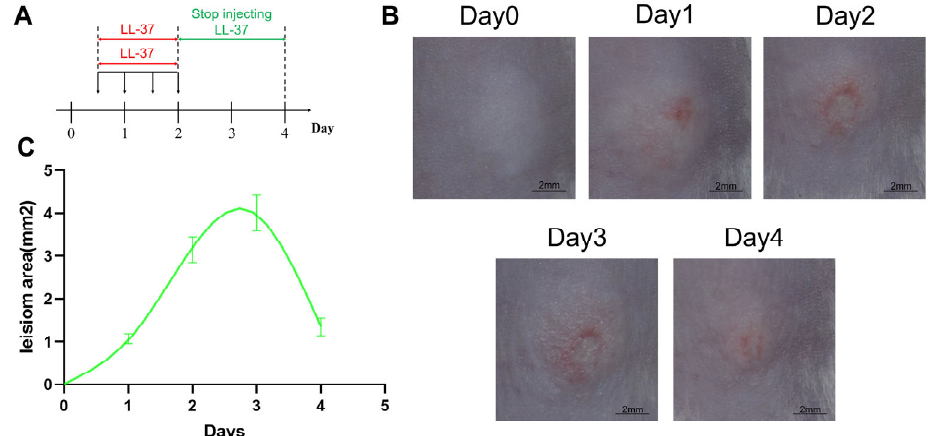
Figure 4. ( A ) The short-term LL-37 administration and self-recovery group received intradermal injections of LL-37 every 12 h for 2 days before being euthanized on days 0, 2, and 4. ( B ) LL-37 intradermal injections were administered for 2 days and then stopped for 2 days, during which erythema changes in the lesion areas of mice on days 0, 1, 2, 3, and 4 from the first injection were recorded (scale bar = 2 mm). ( C ) Trend plot of lesion area. With the extension of LL-37 injection time, the erythema area first expanded; after stopping the injection, the erythema area continued to expand and then gradually shrunk, and there was still a trend of recovery up until the 4th day. Data are presented as the mean ± SD; n = 5 for each group.